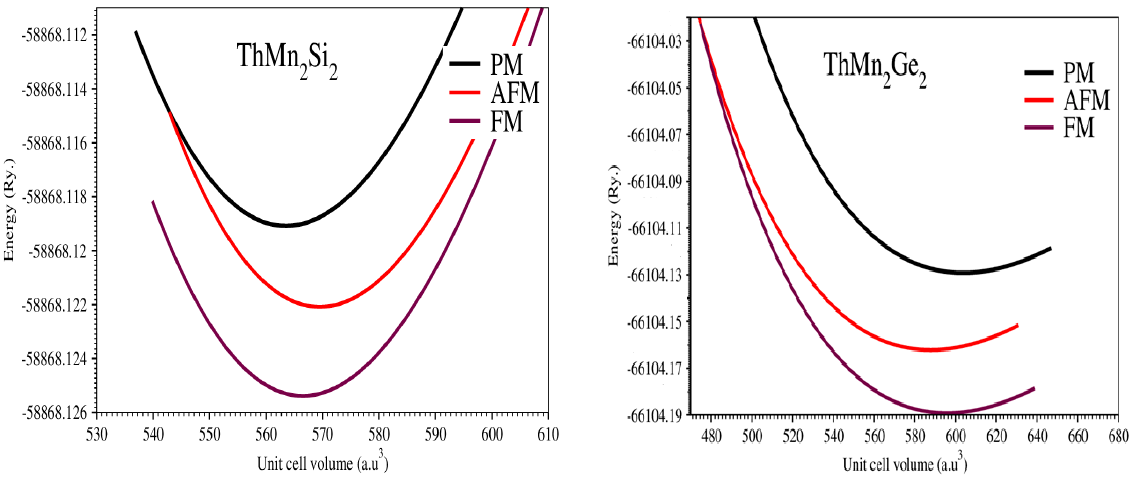
Figure 2. Optimized plots of ThMn 2 Si 2 and ThMn 2 Ge 2 compounds. Table 1. Noted unit cell parameters of ThMn 2 Si 2 and ThMn 2 Ge 2 compounds, together with available experimental